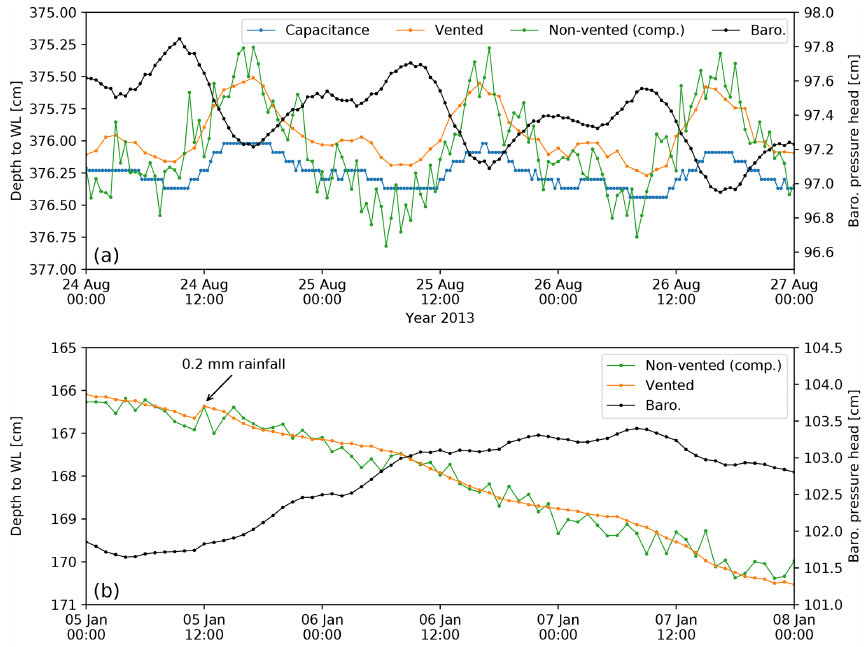
Figure 5. (a) Depth to water level (WL) measured by three different instrument types, illustrating the influence of precision and resolution on head time series: capacitance PT (blue line; high precision and low resolution), vented PT (orange line; high precision and high resolution) and non-vented PT (corrected for barometric pressure; green line; low precision and high resolution). The examples are from (a) Ti Tree basin in the Northern Territory (Australia) and (b) a farm dam in South Australia (note the effect of a 0.2mm rainfall event on 5 January, which is visible in the orange line but not in the green line). The low precision achieved by the non-vented PT is specific to the particular instrument used and not representative of all PTs of this